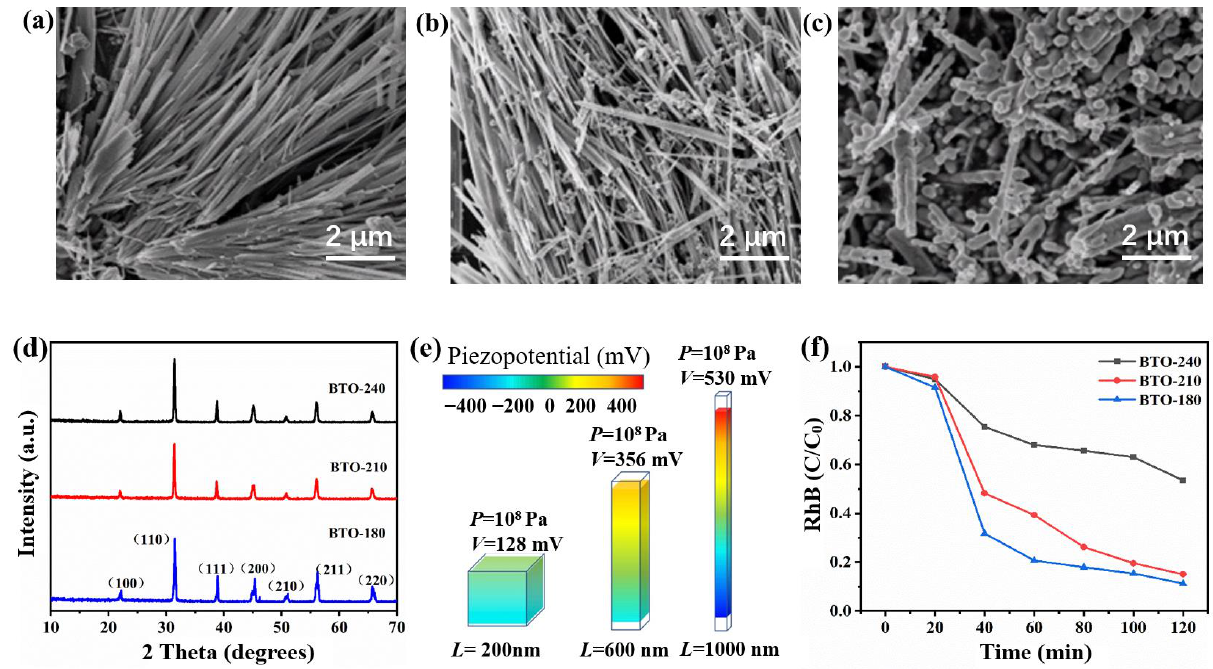
Figure 1. ( a – c ) SEM images of BTO-180, BTO-210, and BTO-240. ( d ) XRD patterns of various samples. ( e ) The influence of deformation on piezoelectric potential. ( f ) The performance of RhB degradation (5 mg/L) on different samples.